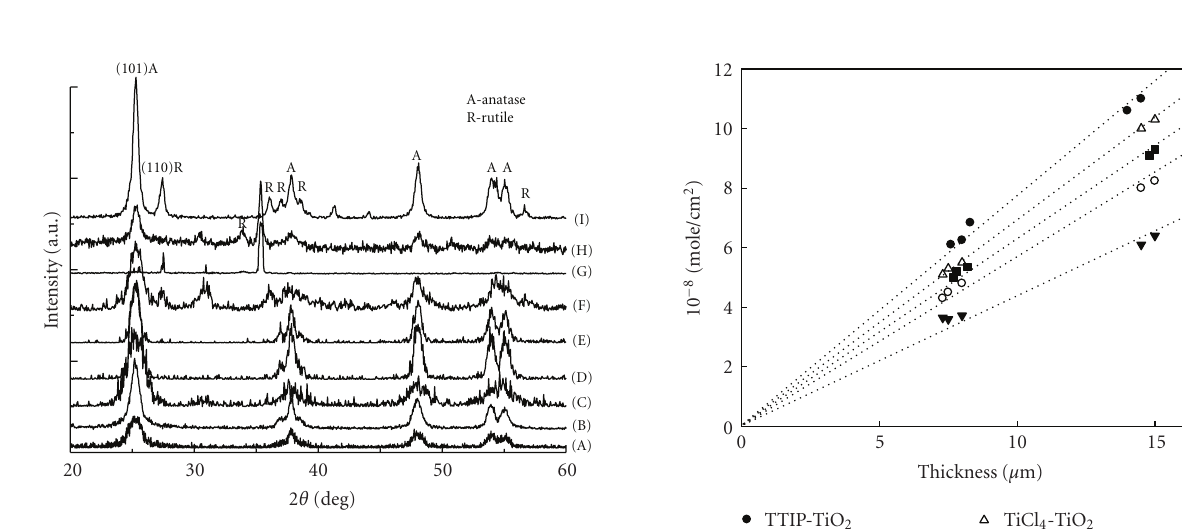
Figure 8: XRD patterns of TiO 2 synthesized hydrothermally at 190 ◦ C for 12 h and calcinated at 500 ◦ C for 0.5h (A: TTIP (190), B: TTIE (190), C: H-TTIP (190), D: TTIP (500), E: TTIE (500), F: H-TTIP (500), G: H-TTIE (500), H: TiCl 4 (500), I: P25).